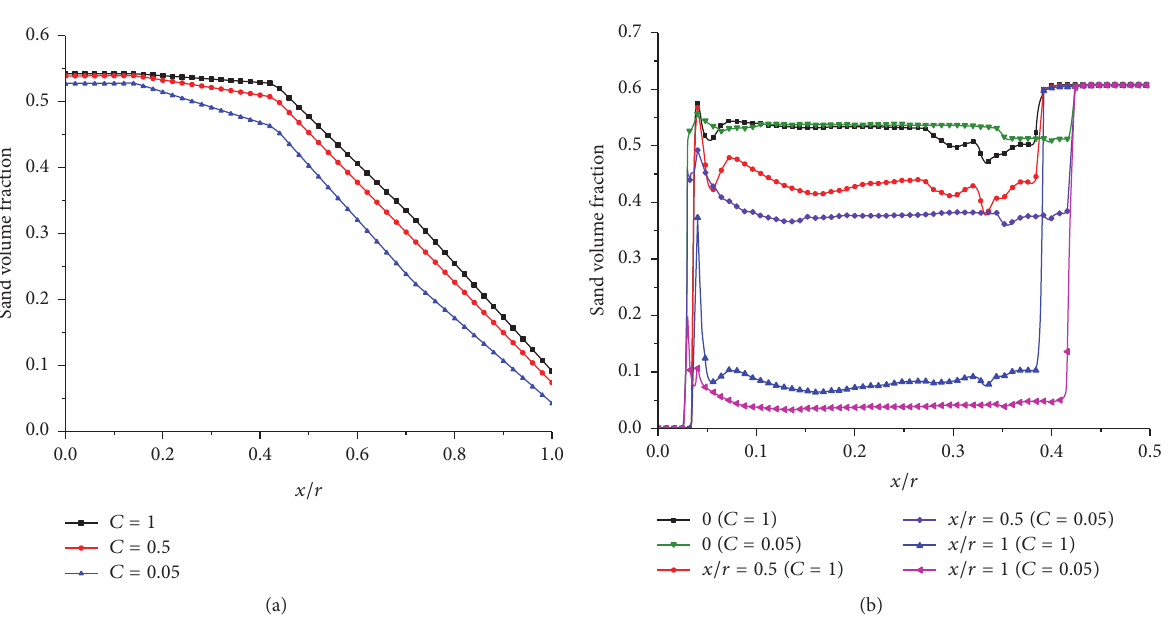
Figure 12: (a) The instantaneous sand volume fraction distribution at the nozzle ( 𝑡 = 70 ms) and (b) the variation of the sand volume fraction at nozzle over time ( 𝑥 is the distance to the axis and 𝑟 is the radius of the